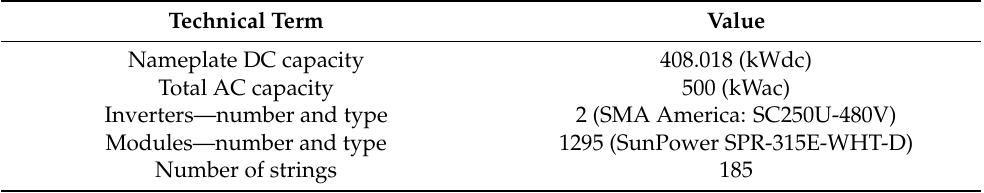
Table 5. Sizing summary of the PV system designed for the case study using SAM.